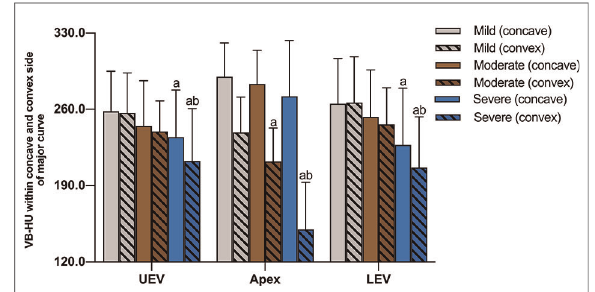
FIGURE 5 Comparison of VB-HU at Apex, UEV, and LEV of the major curve among subgroups; a indicates a signi fi cant difference compared with the mild group; b indicates a signi fi cant difference compared with the moderate